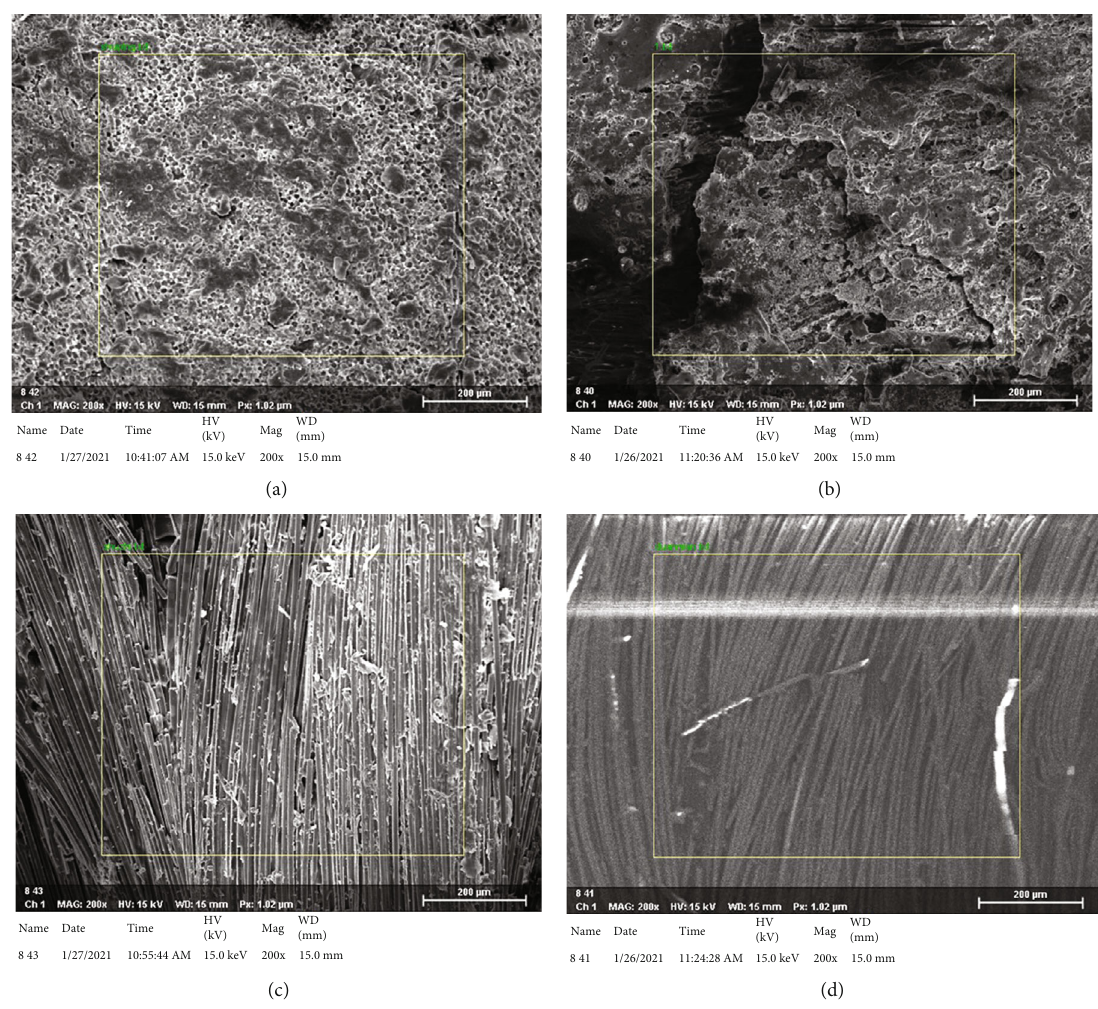
Figure 11: EDS micrograph of the insulation layer: (a) the surface bonded to the throat before the test, (b) the surface bonded to throat after the test, (c) the crack before the test, and (d) the crack after the test. Table 2: EDS results of the surface bonded to the throat. Species Before the test (%) After the test (%) Change value (%)